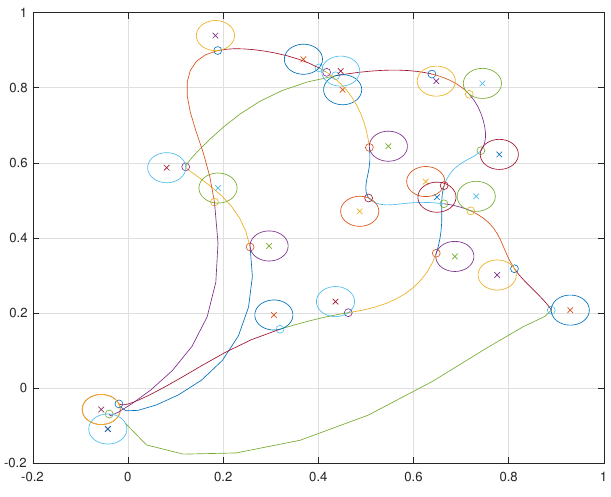
Figure 41. Two agents visiting ten neighborhoods each.